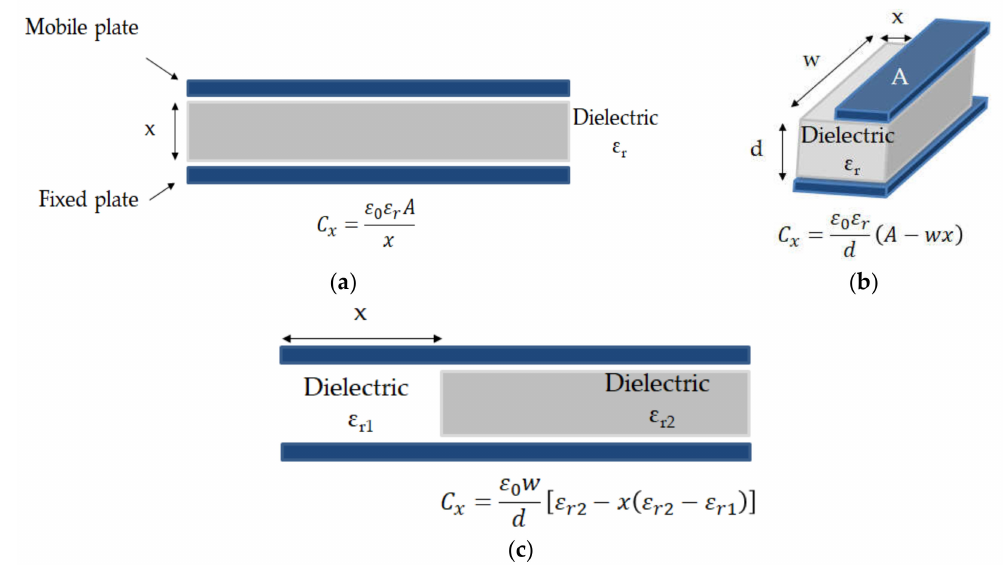
Figure 1. Variables in capacitive sensors: ( a ) Distance ( x ) between plates; ( b ) Capacitor area (electrode moving in x direction); ( c ) Dielectric